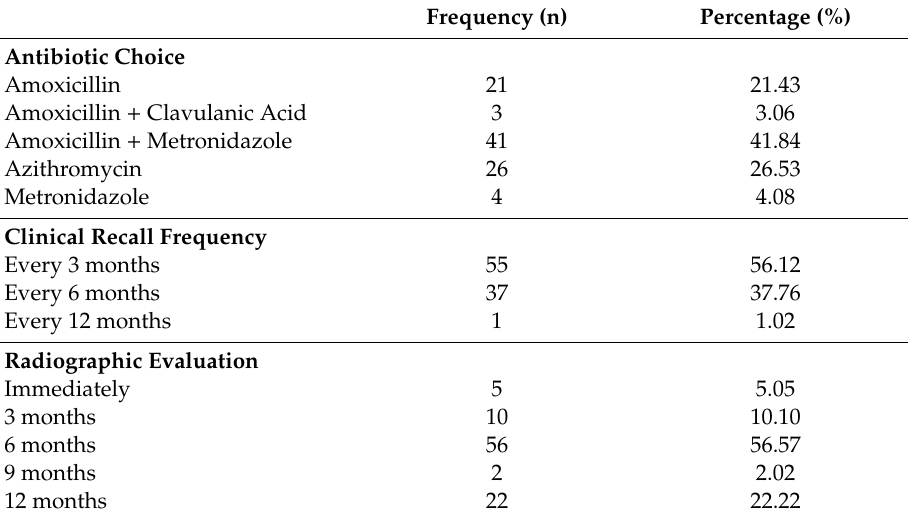
Table 3. Practitioners’ Clinical Management of Peri-Implant